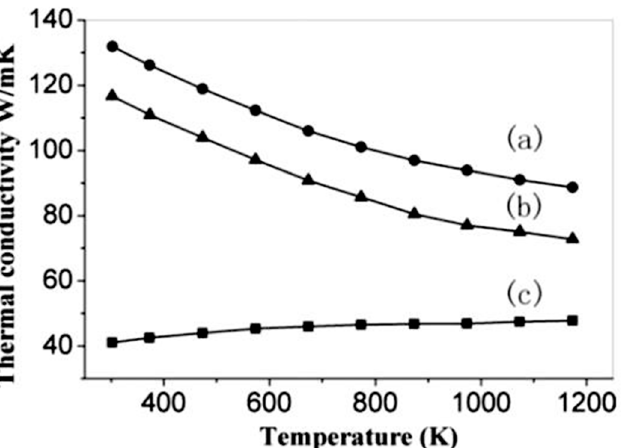
Figure 7. Thermal conductivity: ( a ) carbide ball mill W powders (nm), ( b ) carbide ball mill W powders (micron), ( c ) SS-ball milled W powders (micron) [38].